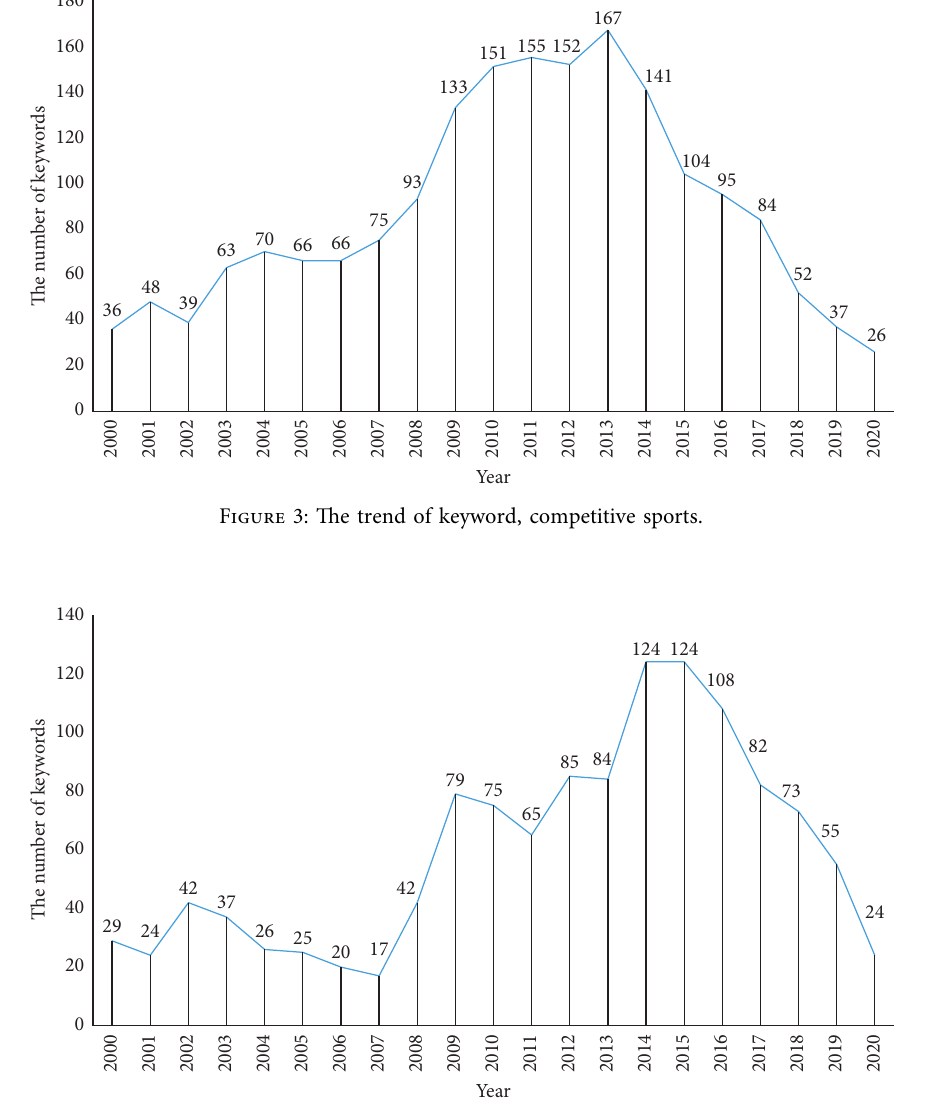
Figure 4: The trend of keyword, mass